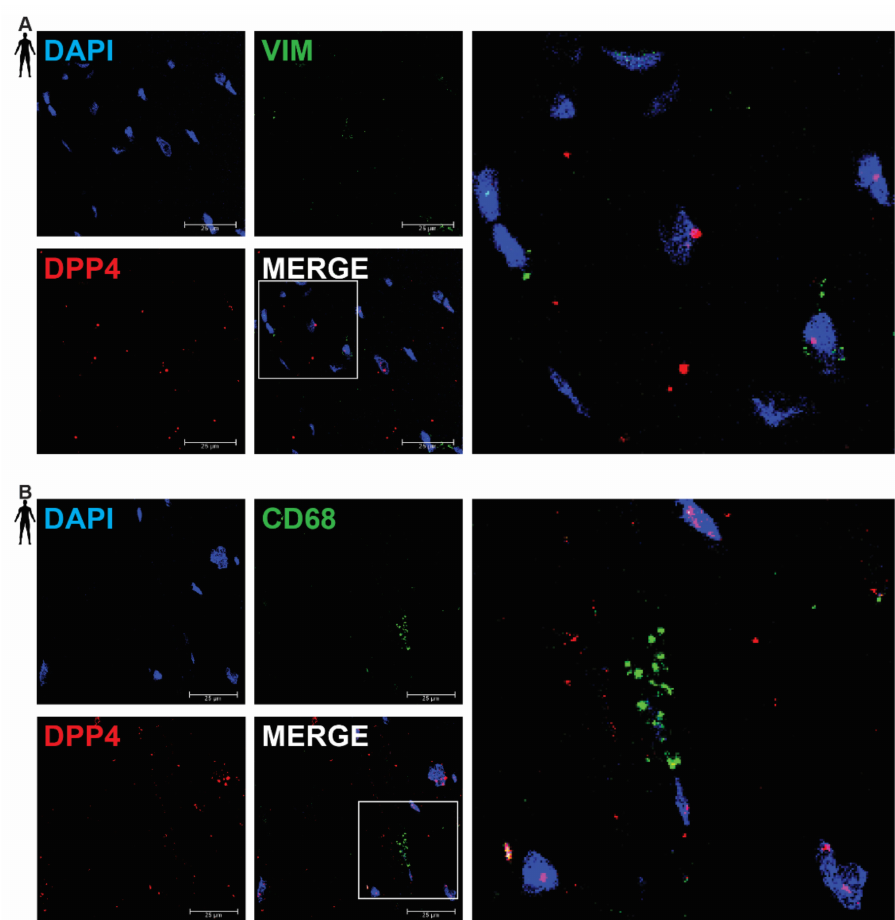
Figure 3. Representative confocal microscopy images of RNA Scope ® -DPP4 mRNA expression in human control left ventricle. Nuclei were stained with DAPI (blue). Fluorescein-labeled tyramide (green) was used to visualize mRNA of VIM (fibroblast marker, ( A )) or CD68 (macrophage marker, ( B )) and Cy3-labeled tyramide (red) was used to visualize mRNA of DPP4, respectively. Scale bar represents 25 µ m. (VIM: vimentin, CD68: cluster of differentiation